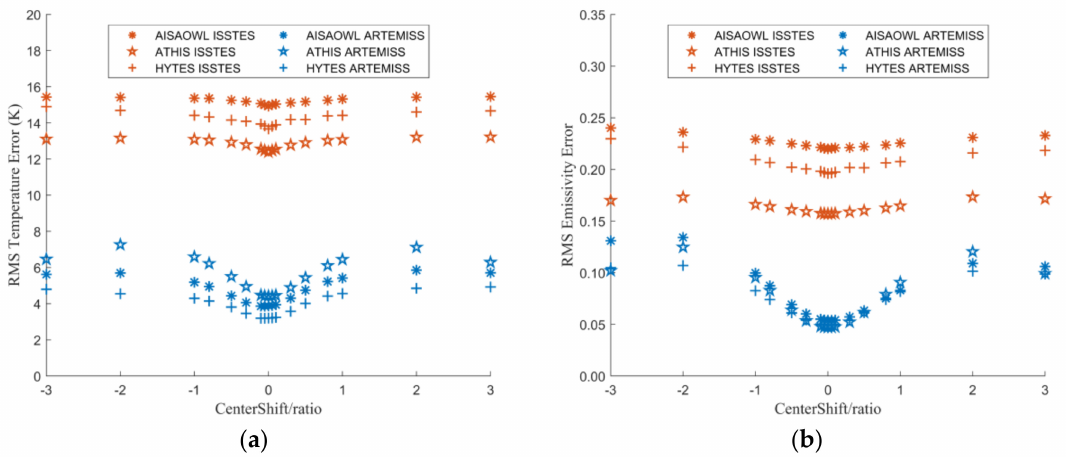
Figure 8. The graph of LST or LSE errors varying with center wavelength shift ratio. The X axis is the center wavelength shift ratio, and the Y axis is the LST error in ( a ) and is the LSE error in ( b ).